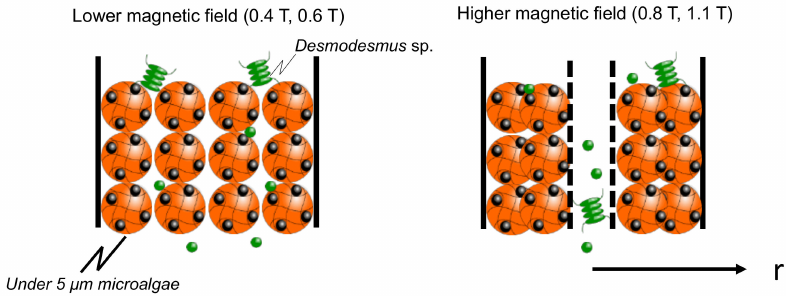
Figure 7. Illustrated image of elution of microalgae at lower and higher magnetic fields.